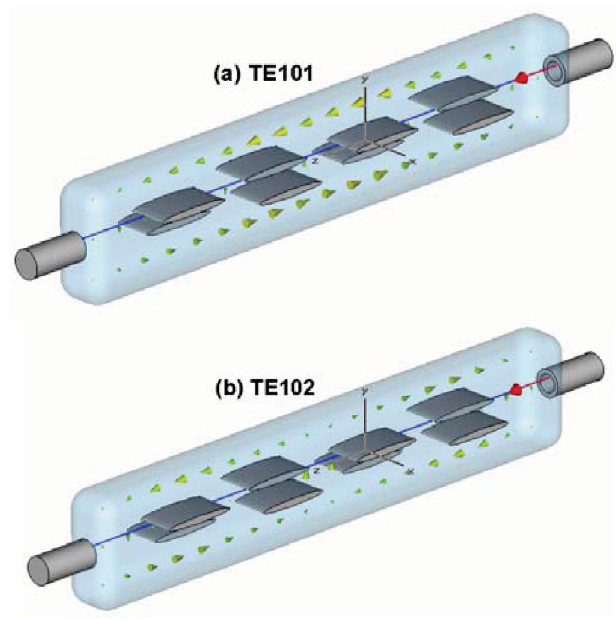
FIG. 12. Phase portrait behind deflector with inverted second part.